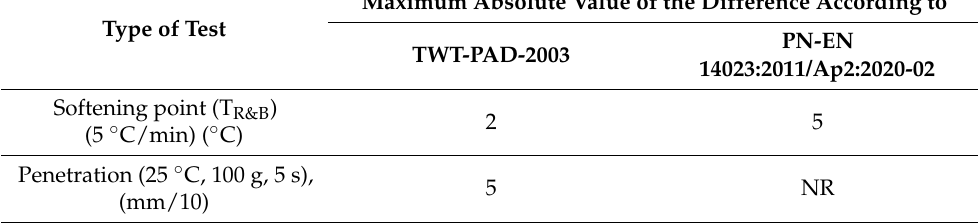
Table 3. Permissible deviations for penetration and softening point (T R&B ) values of polymer- modified bitumen determined in the tube